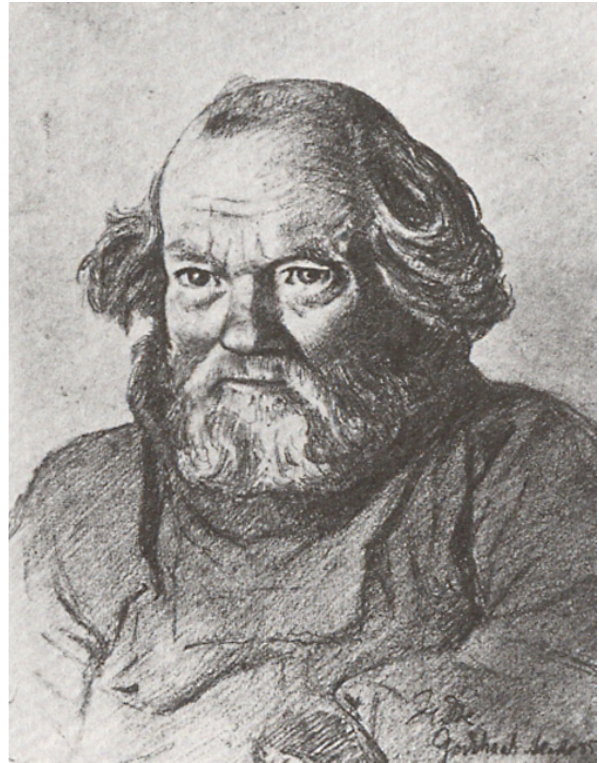
Figure 9. Samuel Petrus Kleinschmidt (1814–1886) (from